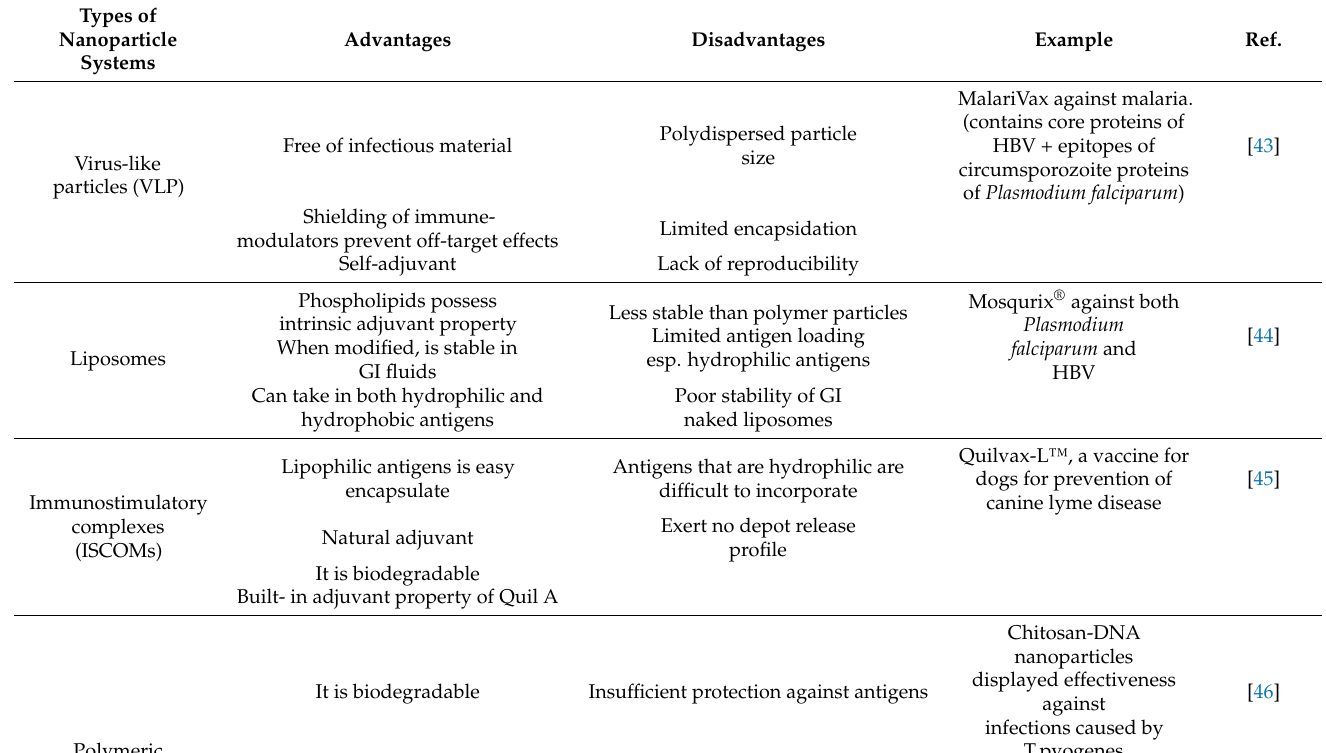
Table 1. Advantages and disadvantages of different nanoparticles in vaccine